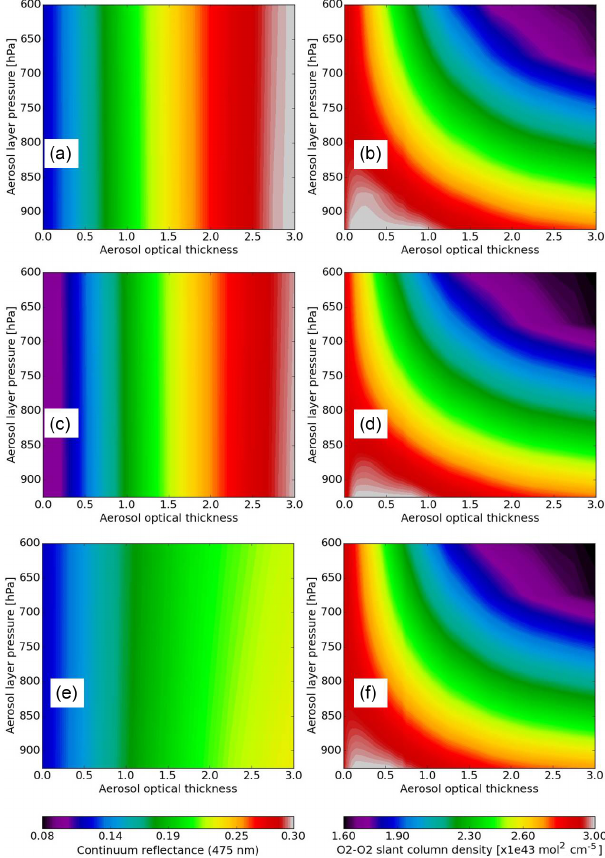
Figure 1. Continuum reflectance R c ( 475nm ) and O 2 − O 2 slant column density N s as a function of τ( 550nm ) and aerosol O 2 − O 2 layer pressure for the following conditions: climatology mid- latitude summer temperature, NO 2 , O 3 and H 2 O profiles, θ 0 = 32 ◦ , θ = 32 ◦ , surface pressure of 1010hPa and fine aerosol particles ( α = 1.5, g = 0.7): (a, b) surface albedo of 0.07 and aerosol ω 0 of 0.95; (c, d) surface albedo of 0.03 and aerosol ω 0 of 0.95; (e, f) sur- face albedo of 0.07 and aerosol ω 0 of